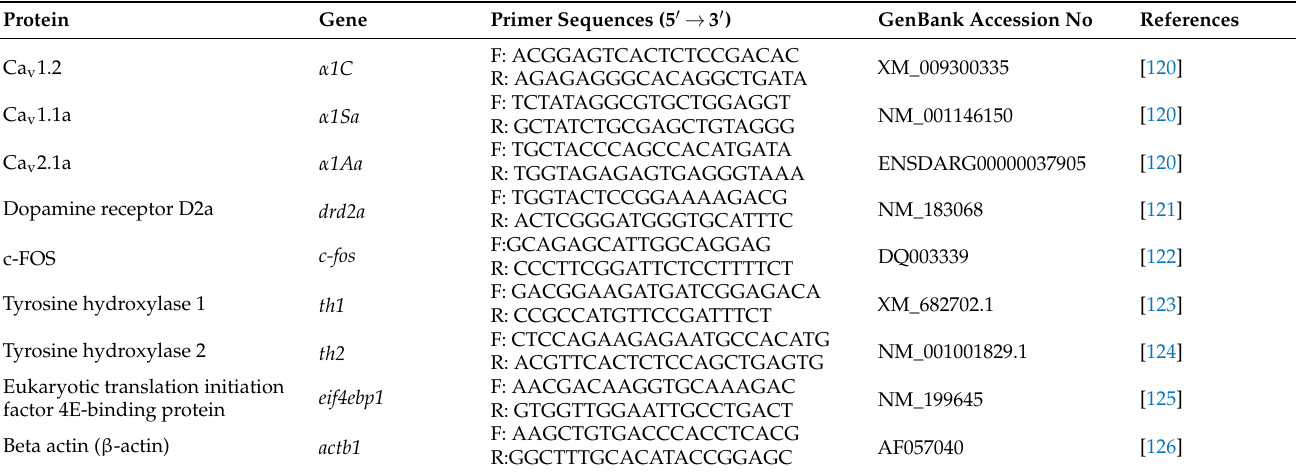
Table 1. Primer sequences of candidate